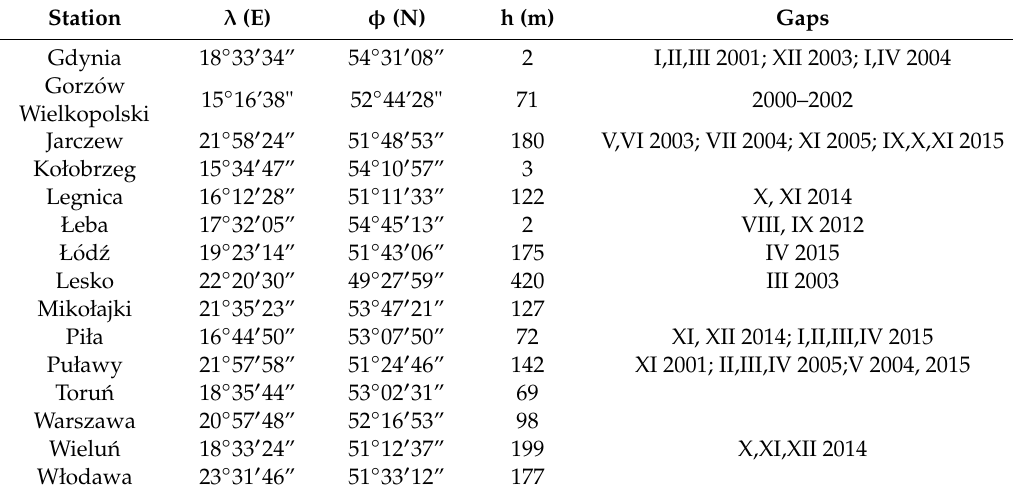
Table 1. Characteristics of stations and dataset used in the analysis